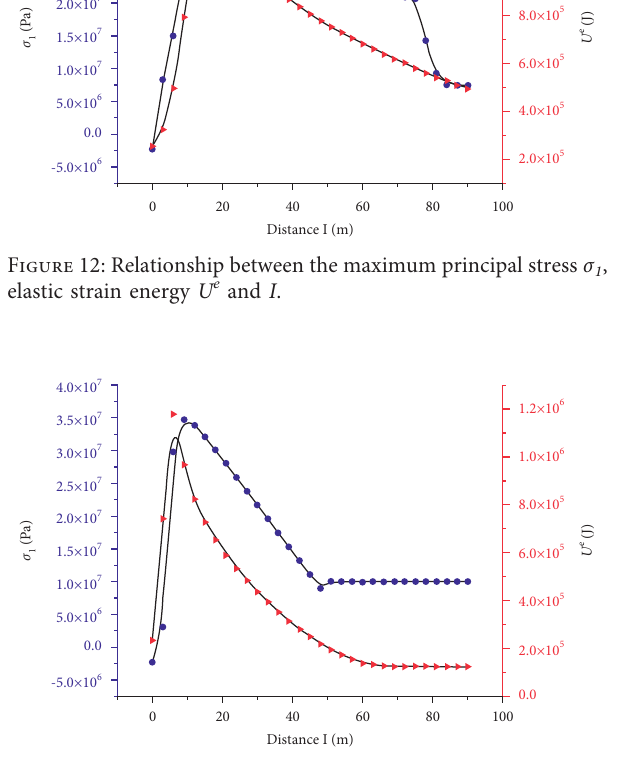
e , and I when the main roof is 1 , U